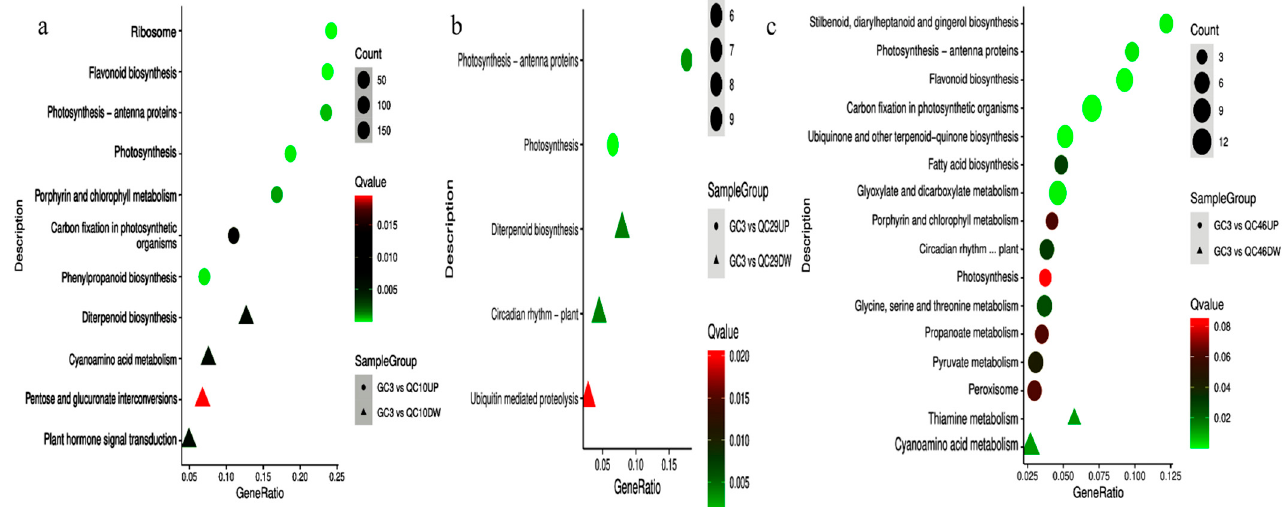
Figure 7. KEGG enrichment of DEGs in the comparisons of QC10 vs. GC3 ( a ), QC29 vs. GC3 ( b ), and QC46 vs. GC3 ( c ), respectively. The areas of bubbles and triangles indicate the number of enriched DEGs, while the color of bubbles indicated Q value.